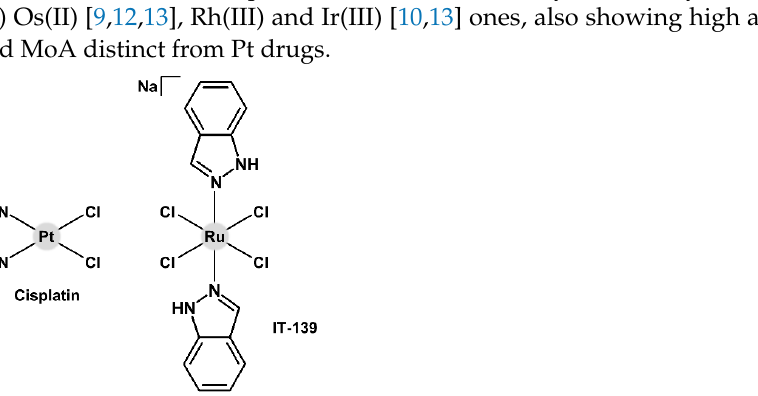
Figure 1. Structural formulas of the platinum-based drug cisplatin and the anticancer ruthenium-based drug candidate IT-139.